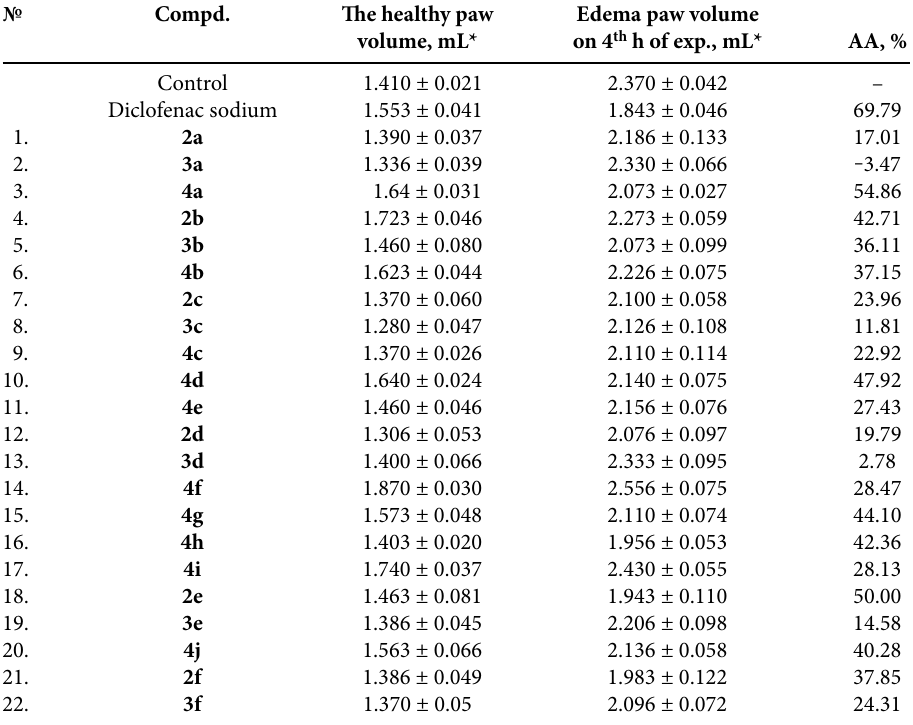
Table 1. Anti-inflammatory activity of the synthesized compounds (M ± m, n = 6)* №